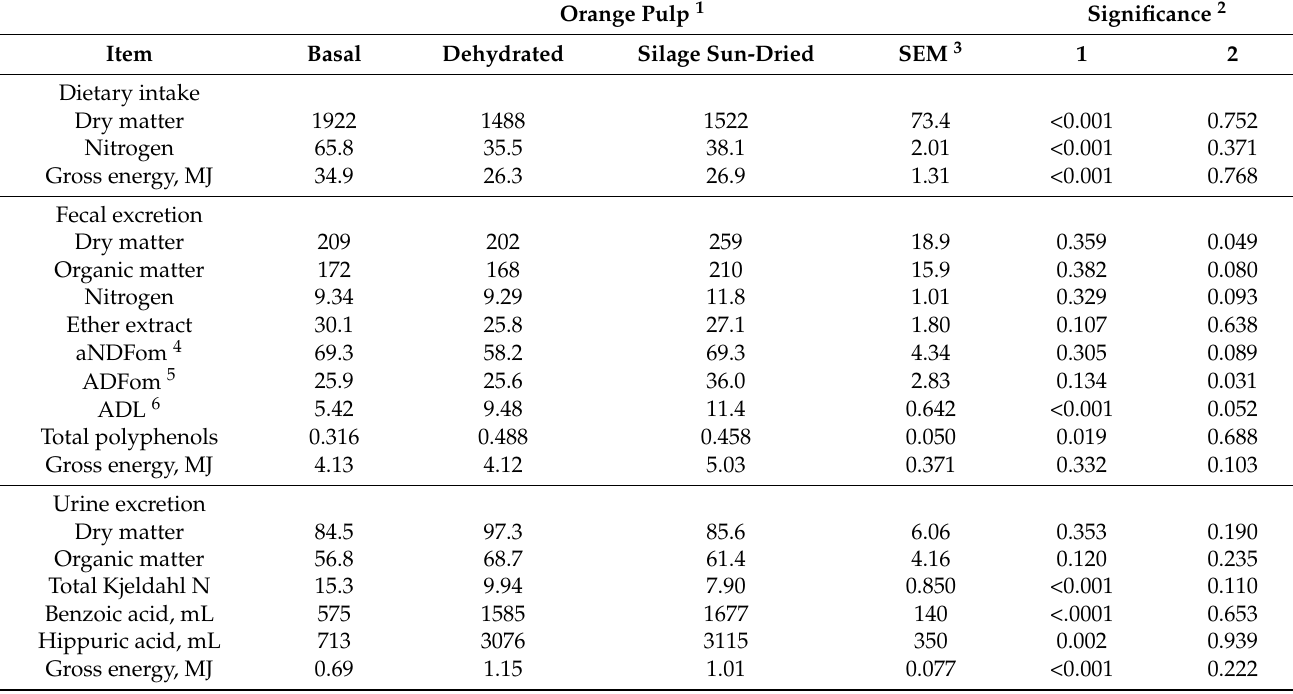
Table 6. Effect of experimental diets on daily nutrient intake and composition of effluents